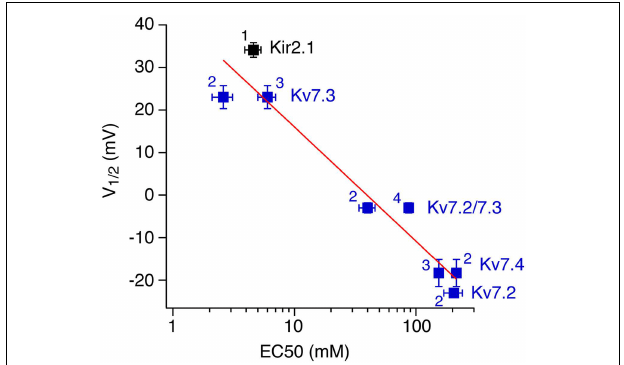
FIGURE 6 | Correlation between V 1 / 2 and apparent affinity for short-chain diC8-PI(4,5)P 2 . For each of the channels examined, voltage of half-inhibition by Ci-VSP in CHO cells is plotted against half-activating concentrations of diC8-PI(4,5)P 2 as reported in the literature (1, Lopes et al., 2002; 2, Li et al., 2005; 3, Zhang et al., 2003; Hernandez et al., 2009). V 1 / 2 -values are taken from Figures 1 , 3 , respectively. Data for Kv7.4 were obtained as shown for Kv7.2 and Kv7.3 ( Figure 3 ). Red line indicates a fit of a logarithmic function to the data, yielding a slope of − 42.8mV per